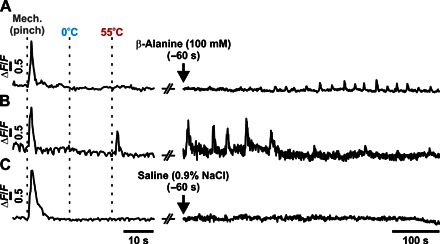
Assessment of sensory modality responses of β-alanine–sensitive neurons in vivo.Example GCaMP3 traces of individual DRG neurons following the application of modality-specific stimuli (mechanical pinch, 0°C water, or 55°C water) and their respective sensitivity to the intraplantar administration of β-alanine (100 mM). Most of the β-alanine–sensitive neurons (n = 5 or 7) were only responsive to mechanical stimuli (A), with few responding to both mechanical and heat stimuli (B) (n = 2 or 7). A typical trace following saline (0.9% NaCl) administration is also shown (C).